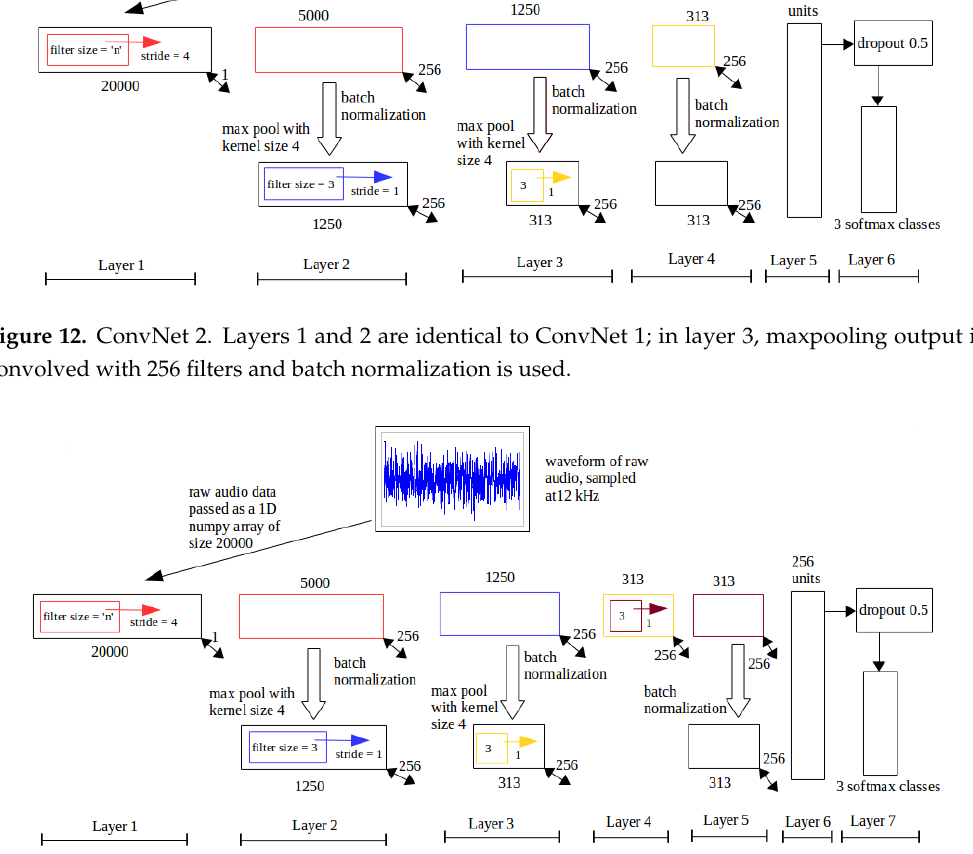
Figure 13. ConvNet 3. Layers 1, 2, and 3 are identical to the same layers in ConvNet 2; in layer 4, the output is convolved with 256 filters and batch normalization is performed in layer